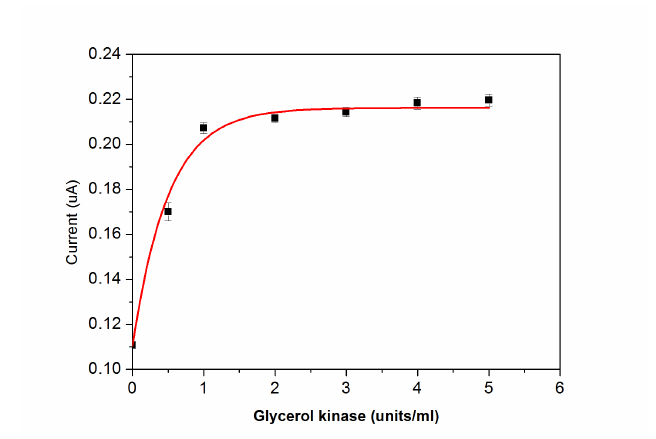
Figure 7. Optimization of glycerol kinase in bovine